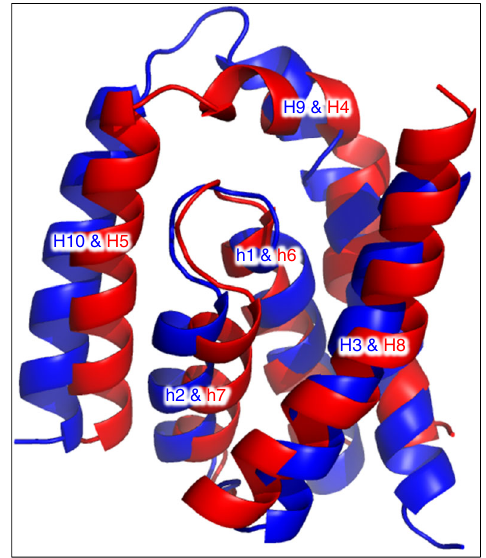
Fig. 7 Superposition of domains 1 and 2 in BacA. The C α r.m.s.d between superposed domain 1 (blue) and domain 2 (red) over 108 residues is 2.34 Å. The view is in the membrane